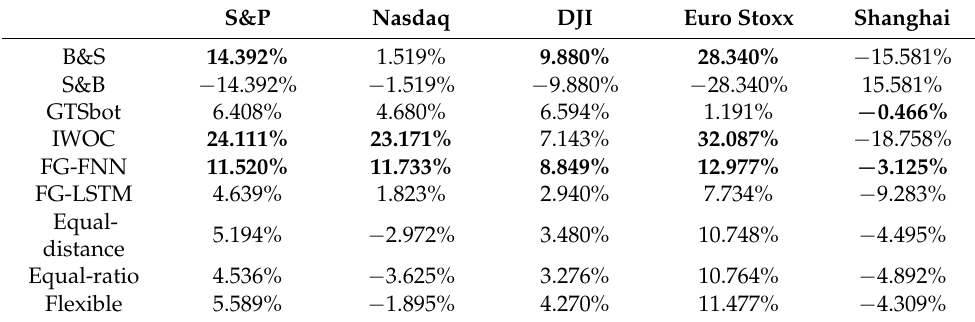
Table 16. Comparison of ROI.